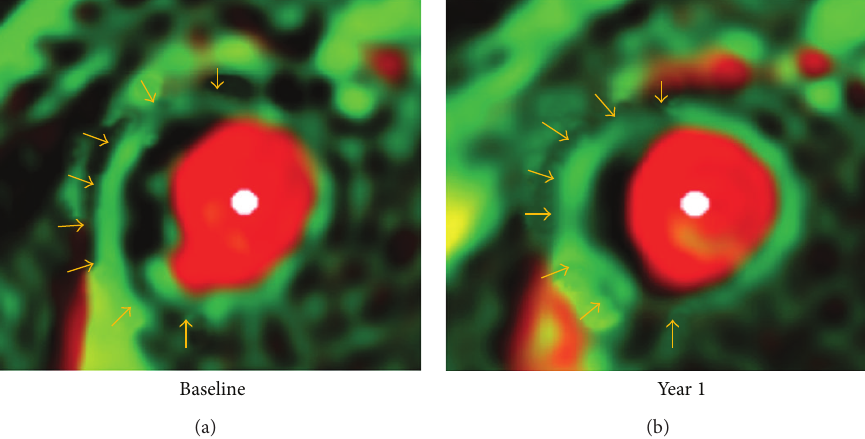
Figure 5: Vasa vasorum images in a 63-year-old man with hypertension. Adventitial transfer constant was 0.129 min −1 before therapy and 0.099 min −1 after 1-year treatment. There was subtle gradation of color in adventitial zone (arrows). Reprint with permission from